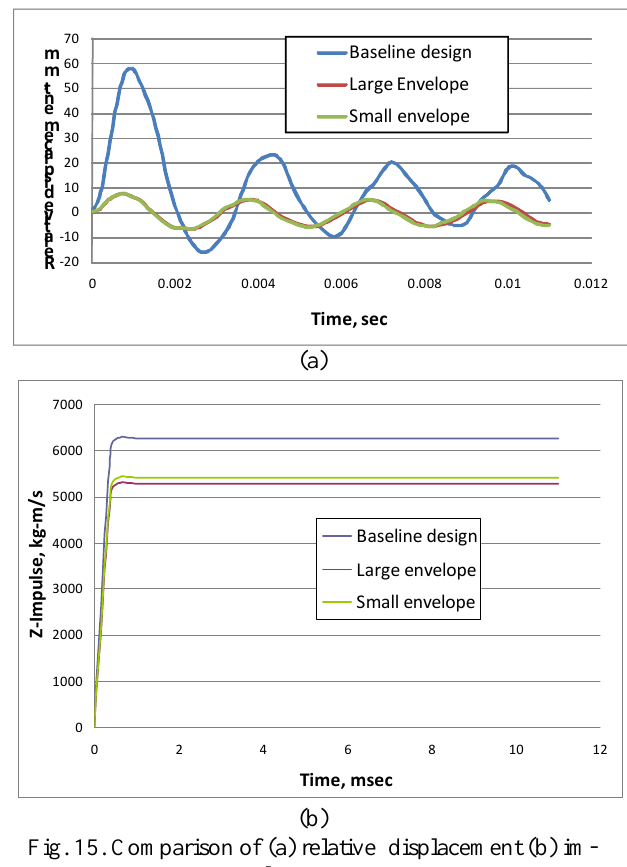
Fig. 15. Comparison of (a) relative displacement (b) im- pulse